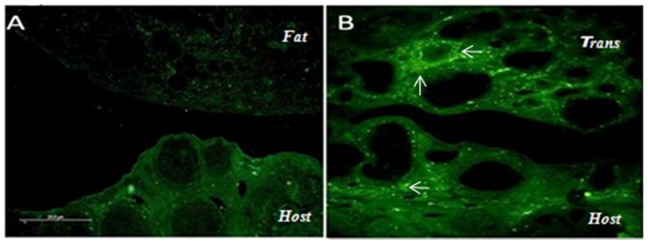
Fluorescence image of kit ligand.The expression level of kit ligand (←) in both the host and transplanted (trans) ovaries of the GOT group (Fig. 14B) is remarkably higher than that of follicle-deficient-ovary of the GFT group (Fig. 14A). Each image is one representative of five replicates, each from independent rats of the respective groups.